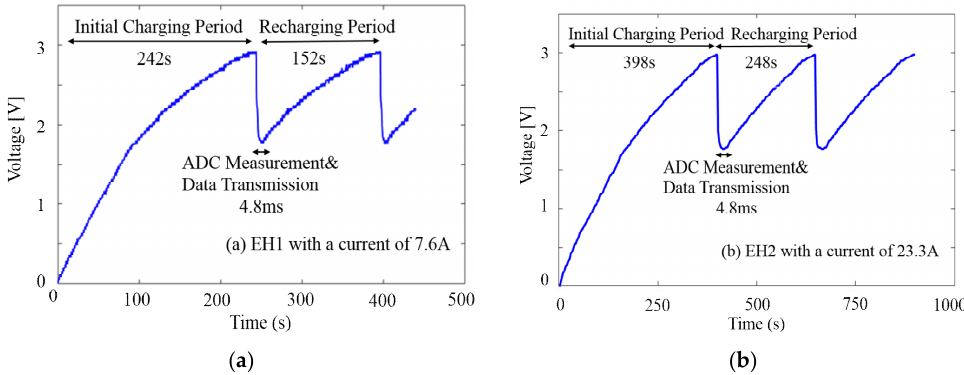
Figure 11. Charging/discharging behavior of the storage capacitor for WSN operations when the current in the wire is ( a ) 7.6 A (with EH1) and ( b ) 23.3 A (with EH2), respectively. In the beginning, it